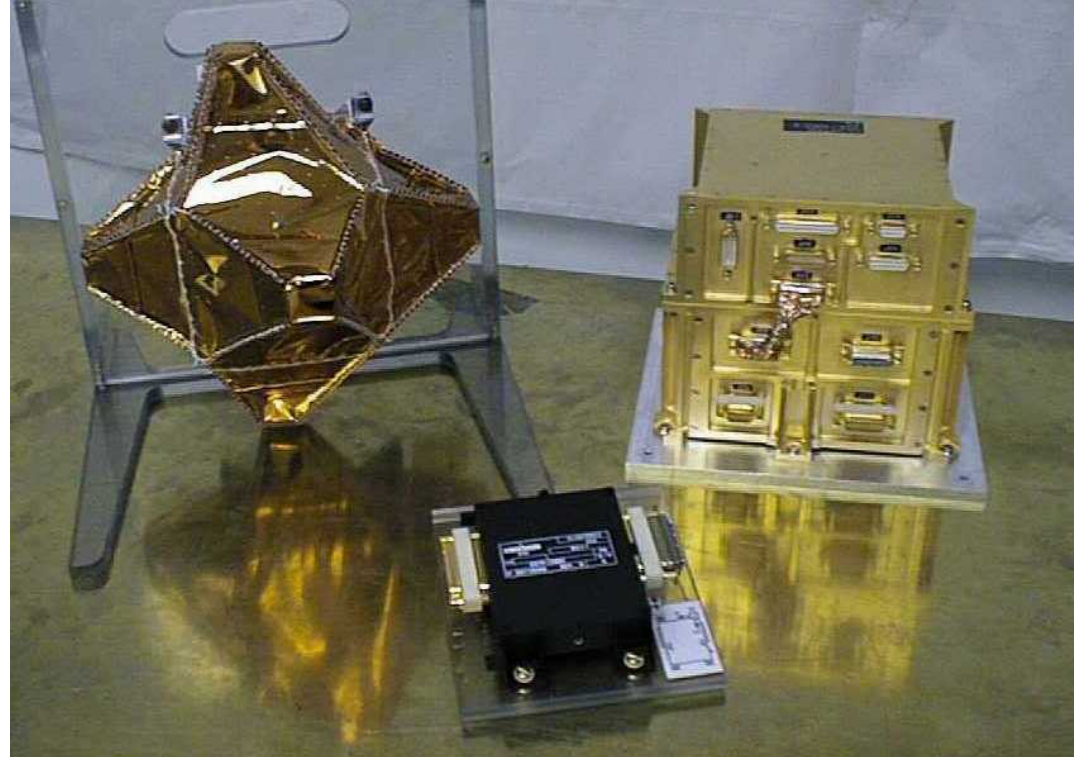
Fig. 1. Picture of the STAFF experiment in a clean room at V´elizy. At the left are the three orthogonal search coils under their thermal blanket. In the middle the preamplifier and on the right-hand side is the electronics box which comprises two parts; at the bottom the Spectrum Analyser built by DESPA, Meudon, on top of which is the waveform analyser (CETP).